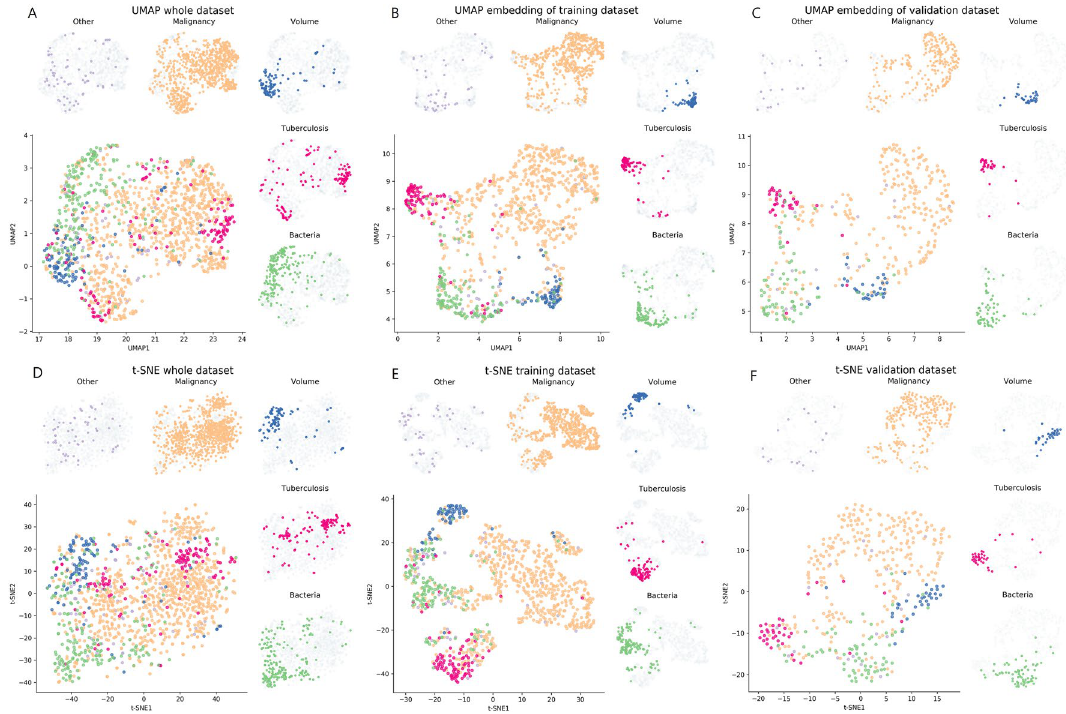
Figure 4. Embedding space of the contrastive-loss model in the validation dataset. The raw laboratory results are visualized in the embedding space of UMAP and t-SNE. ( A , D ) When the results are passed through the encoder of the contrastive-loss model, the laboratory results are divided according to each etiology in the training set ( B , E ) and validation set ( C , F ).